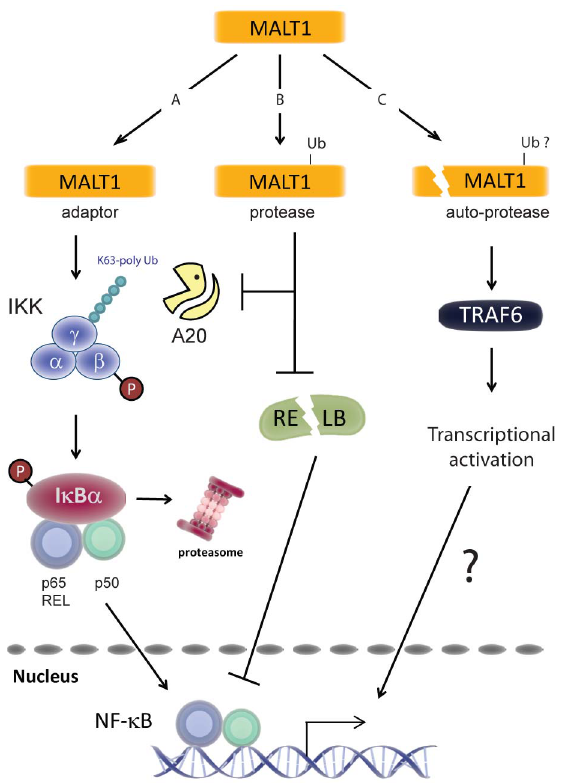
Figure 8. Model for MALT1 functions in TCR-mediated NF- k B1 activation. A) The adaptor function of MALT1 is required for TCR- mediated activation of the IKK complex. Via formation of the CARMA1/ BCL10/MALT1 complex MALT1 controls TRAF6-mediated K63 poly- ubiquitination of the gamma subunit of the IKK complex. Concurrent phosphorylation of IKK b activates the IKK complex that phosphorylates the NF- k B inhibitor I k B, induces its proteasomal degradation and allows nuclear translocation of NF- k B complexes consisting of p50, p65 and REL. B) Parallel induction of MALT1 protease activity prevents de- ubiquitination of IKK c and possibly other substrates via A20 cleavage and facilitates DNA binding of p65- or REL-containing NF- k B complexes via RELB cleavage. C) MALT1 auto-proteolysis represents a third level of MALT1 regulation that controls in a TRAF6-dependent and BCL10- independent manner the transcriptional activation of nuclear NF- k B complexes via a yet unknown mechanism. resin according to the manufacturer’s protocol (IBA). Purified F- STII-MALT1 (1 m g) was incubated at 37 u C for 2 h in a total volume of 25 m l paracaspase assay buffer (50 mM MES, pH 6.8, 150 mM NaCl, 10% (wt/vol) sucrose, 0.1% (wt/vol) CHAPS (3- [(3-cholamidopropyl)-dimethylammonio]-1-propane sulfonate hy- drate), 10 mM dithiothreitol and 0.2, 0.4, 0.6 or 0.8 M NH 4 - citrate respectively, with or without MALT1 protease inhibitors z- VRPR-fmk (Bachem AG) and z-LVSR-fmk (Bachem AG). An buffer containing 50 m M Ac-LVSR-AMC (Genecust) to measure MALT1 protease activity. 25 m l reactions in 384-well black plates (Greiner Bio One) were measured with excitation/emission